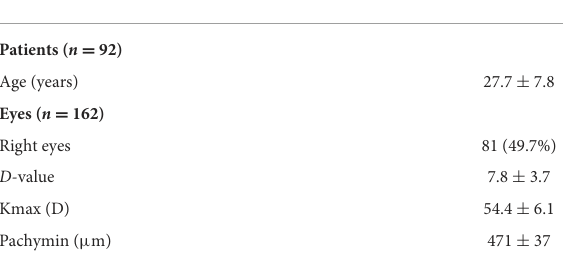
TABLE 1 Patient